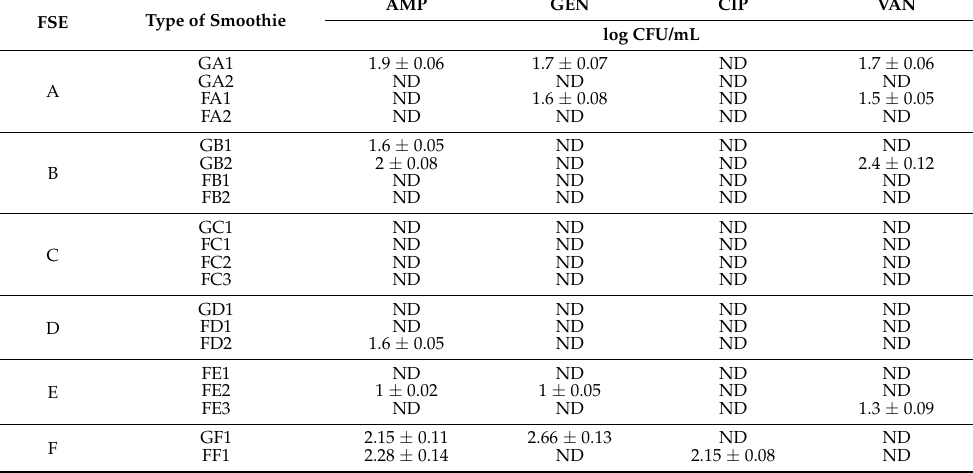
Table 5. Occurrence antibiotic-resistant enterococci in the smoothie